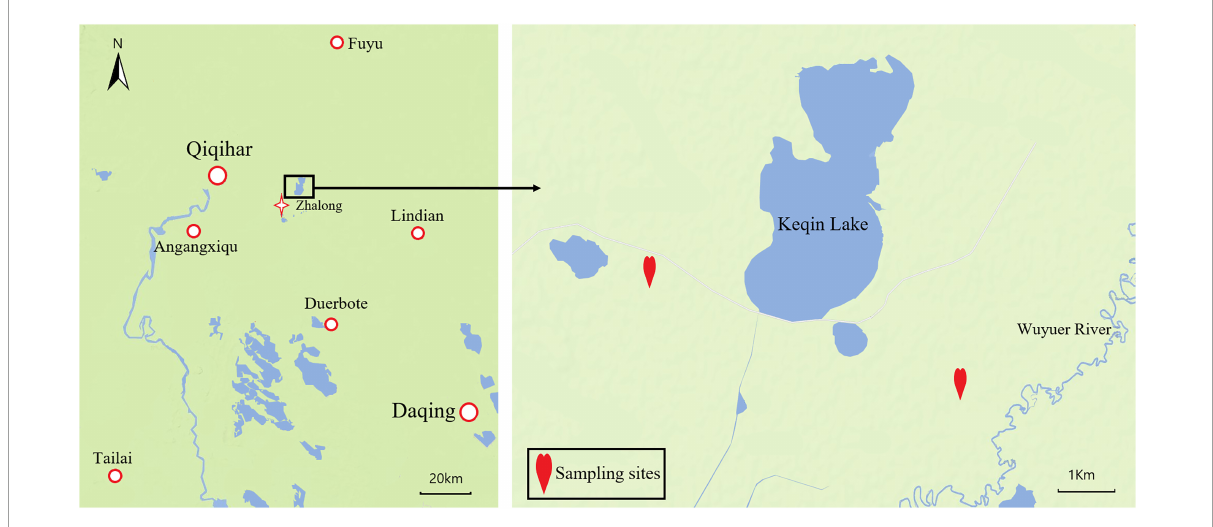
FIGURE1 Map of geographical location of the Zhalong China and sampling